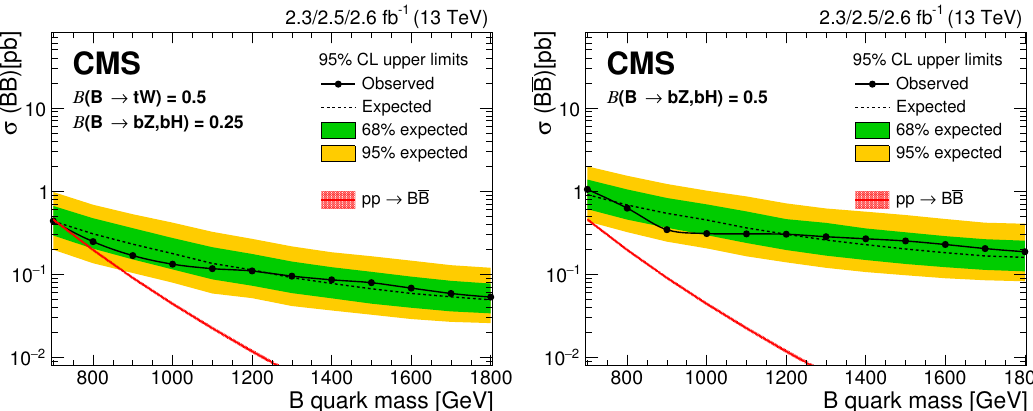
Figure 13 . The expected and observed upper limits (Bayesian) at 95% CL on the cross section of BB production for the singlet benchmark (left) and the doublet benchmark (right) after combining the boosted W and boosted H channels. The theoretically predicted cross section for BB production calculated at NNLO is shown as red line, with the uncertainties in the PDFs and renormalization and factorization scales indicated by the shaded area. Masses below 700 GeV were excluded previously.